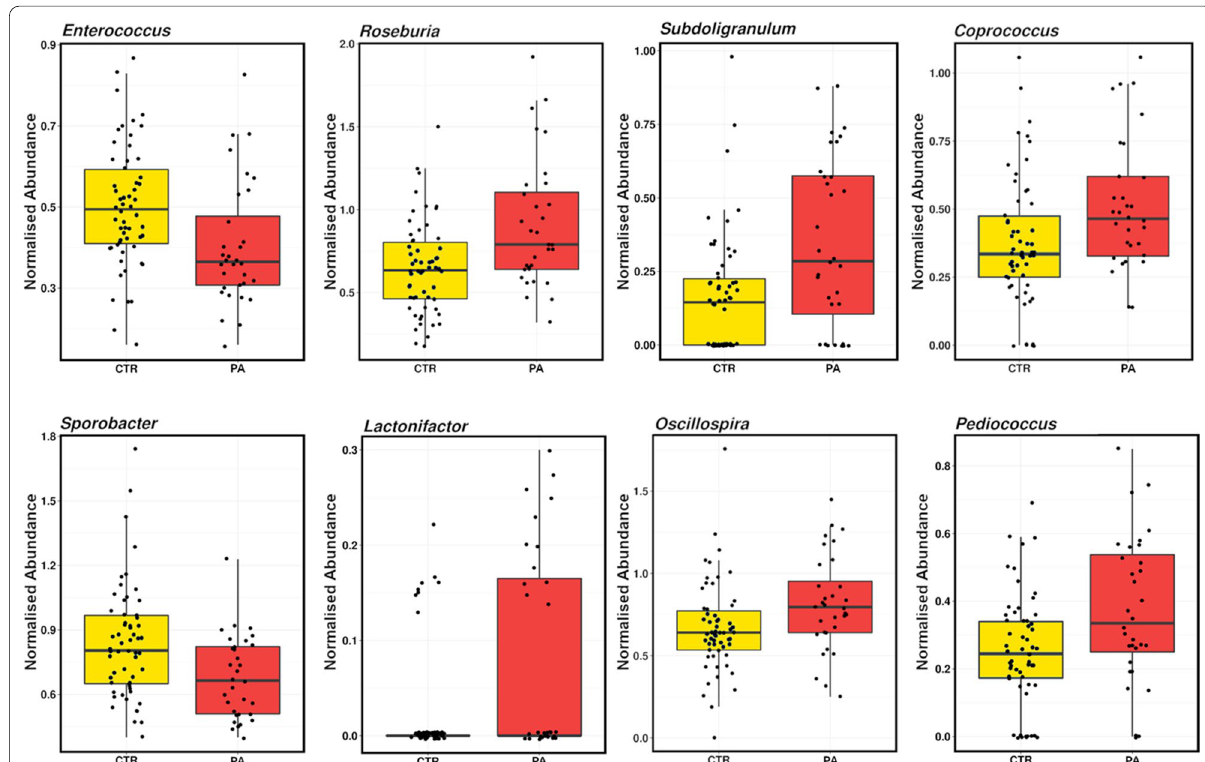
Fig. 1 Classified genera significantly altered ( P < 0.01) in the faeces of sows fed two different diets: a control diet (CTR), and a control diet supplemented with a PA during gestation